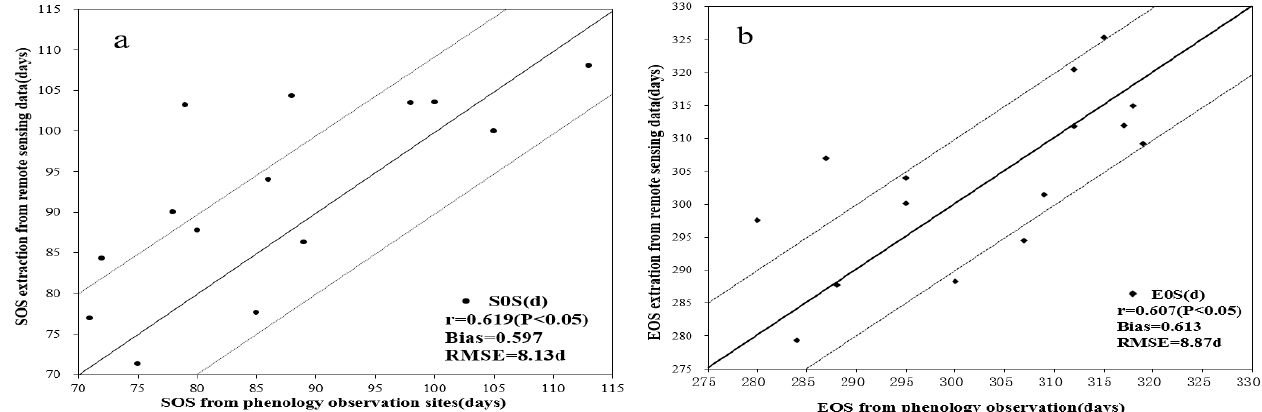
Figure 2. Correlation of grassland vegetation ( a ) SOS and ( b ) EOS between the NDVI from MOD13A1 data and ground observations.